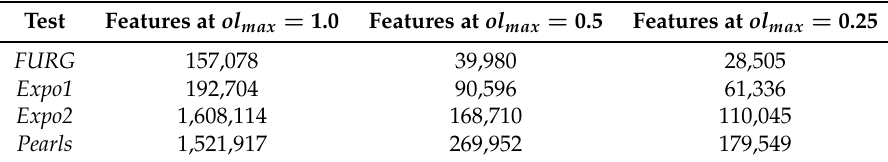
Table 4. Detected visual features for every test when varying ol max